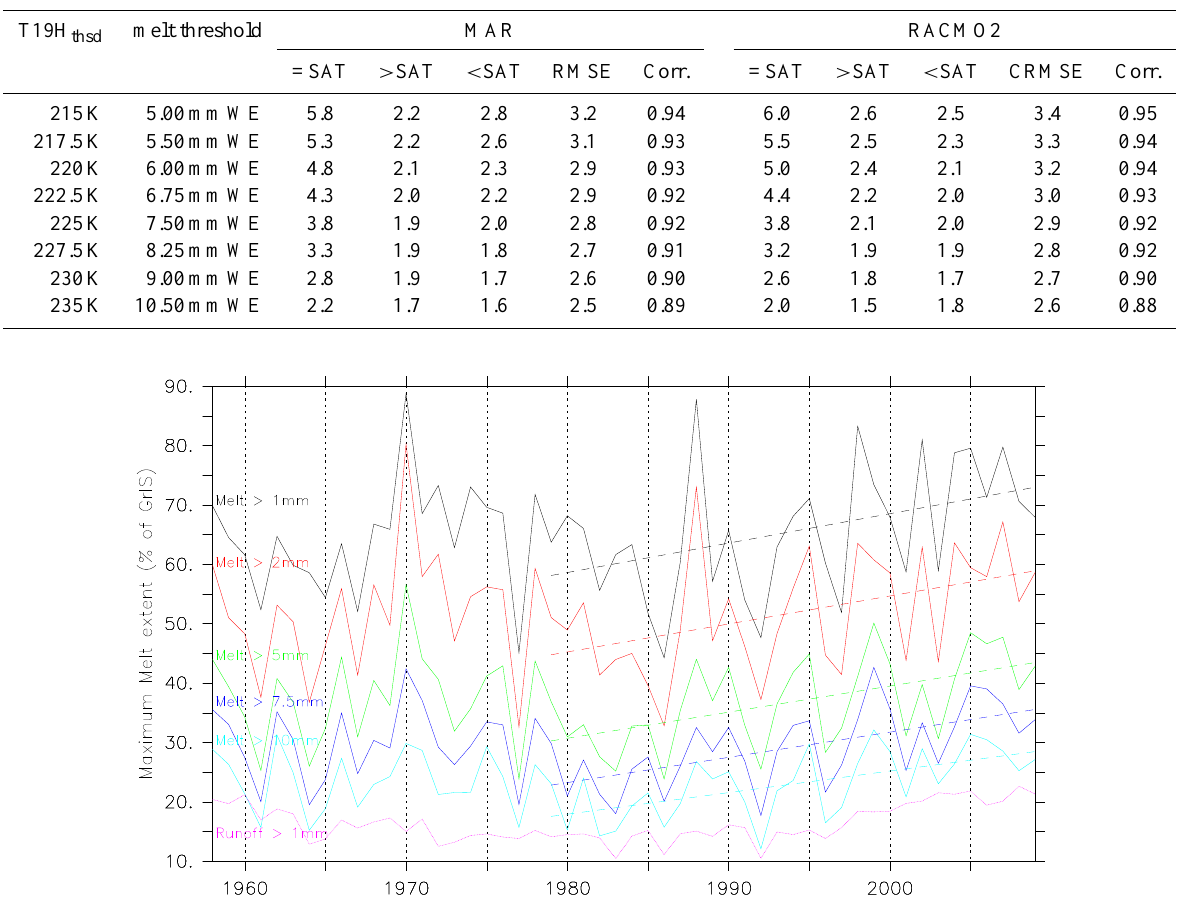
Fig. 2. Time series of the maximum melt extent (in percentage of the GrIS area) simulated by MAR for different melt thresholds: daily meltwater production higher than 1, 2, 5, 7.5 and 10mmWE and daily runoff higher than 0mmWE. Finally, the linear trend over 1979–2009 is given in dashed line.